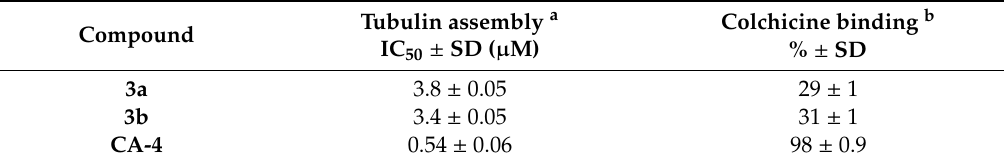
Table 2. Inhibition of tubulin polymerization and colchicine binding by compounds 3a , 3b , and CA-4.